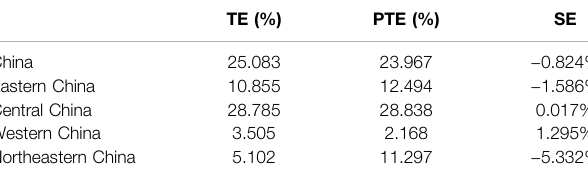
TABLE 7 | The adjustment range of fi rst and third